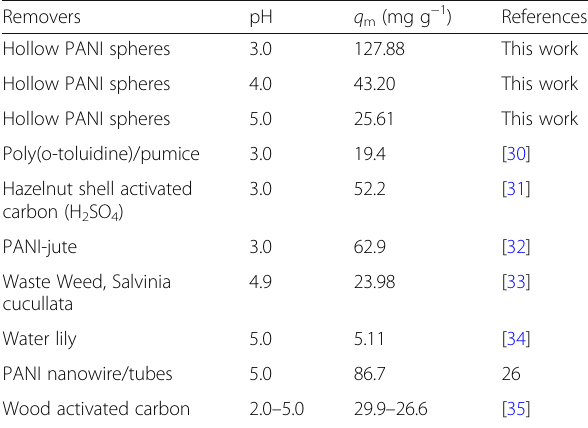
Table 1 Comparison of the maximum removal capacity of Cr (VI) on various removers Removers pH